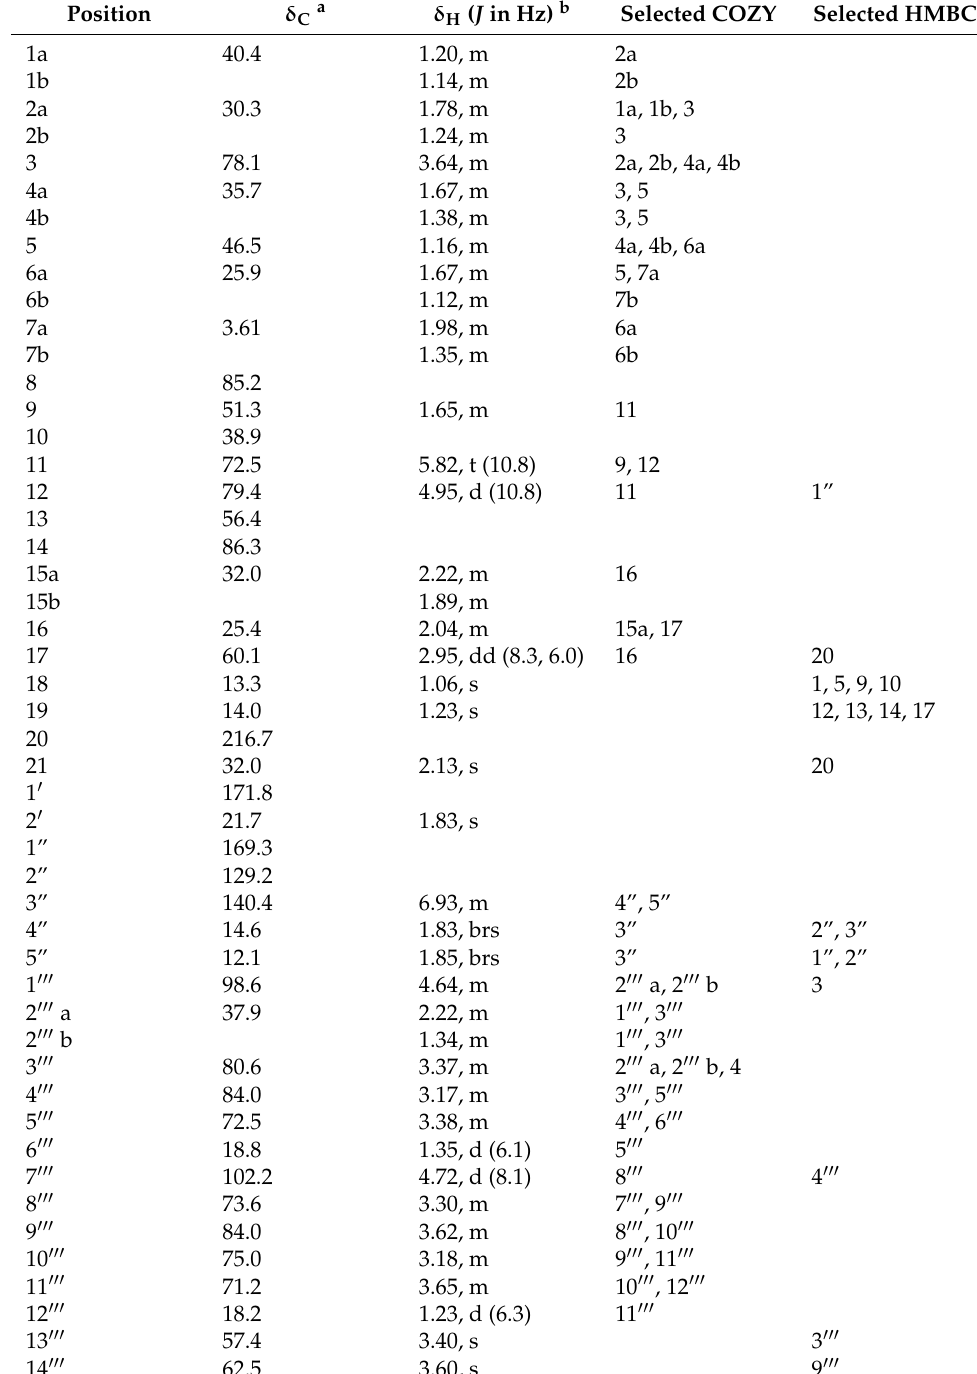
Table 2. 1 H and 13 C-NMR data of compound 1 in CD 3